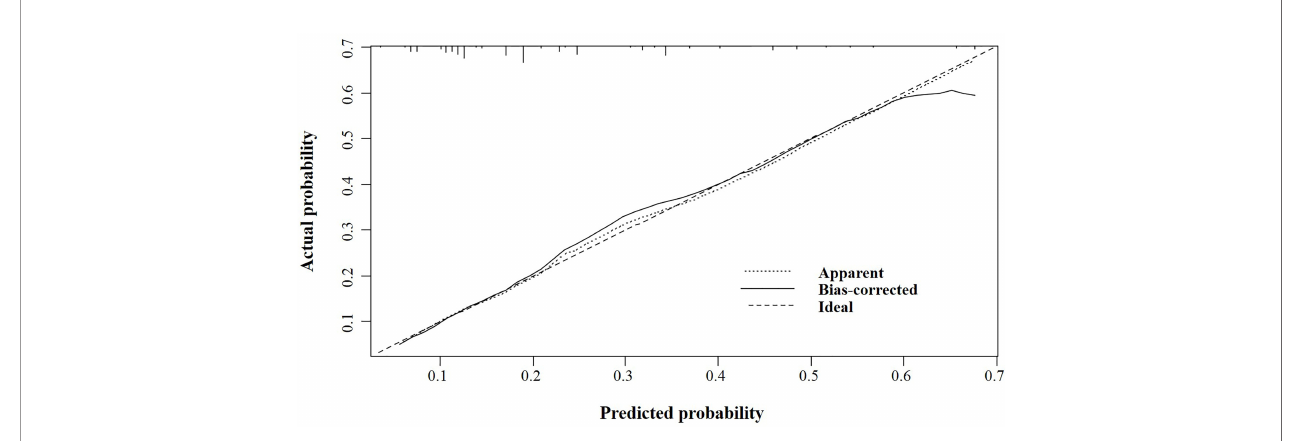
FIGURE 5 | The calibration curve for assessing the calibration of the nomogram in predicting all cause of early death in the